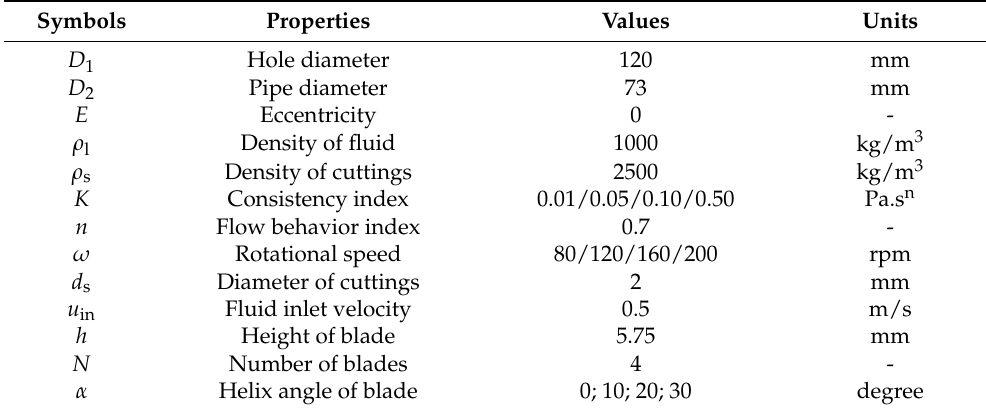
Table 1. Detailed parameters used in simulations.